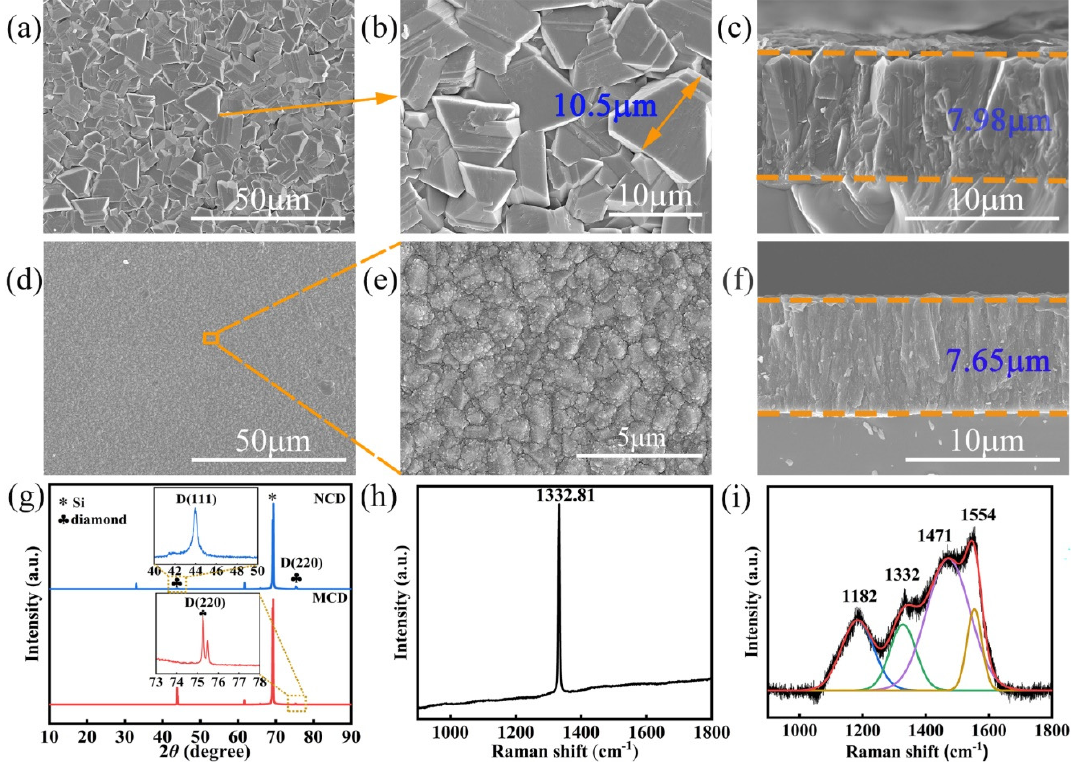
Figure 2. The surface and cross-sectional morphologies of diamond coatings: ( a – c ) MCD; ( d – f ) NCD; ( g ) The XRD pattern of diamond coatings; ( h ) The Raman spectrum of MCD coatings; ( i ) The Raman spectrum of NCD